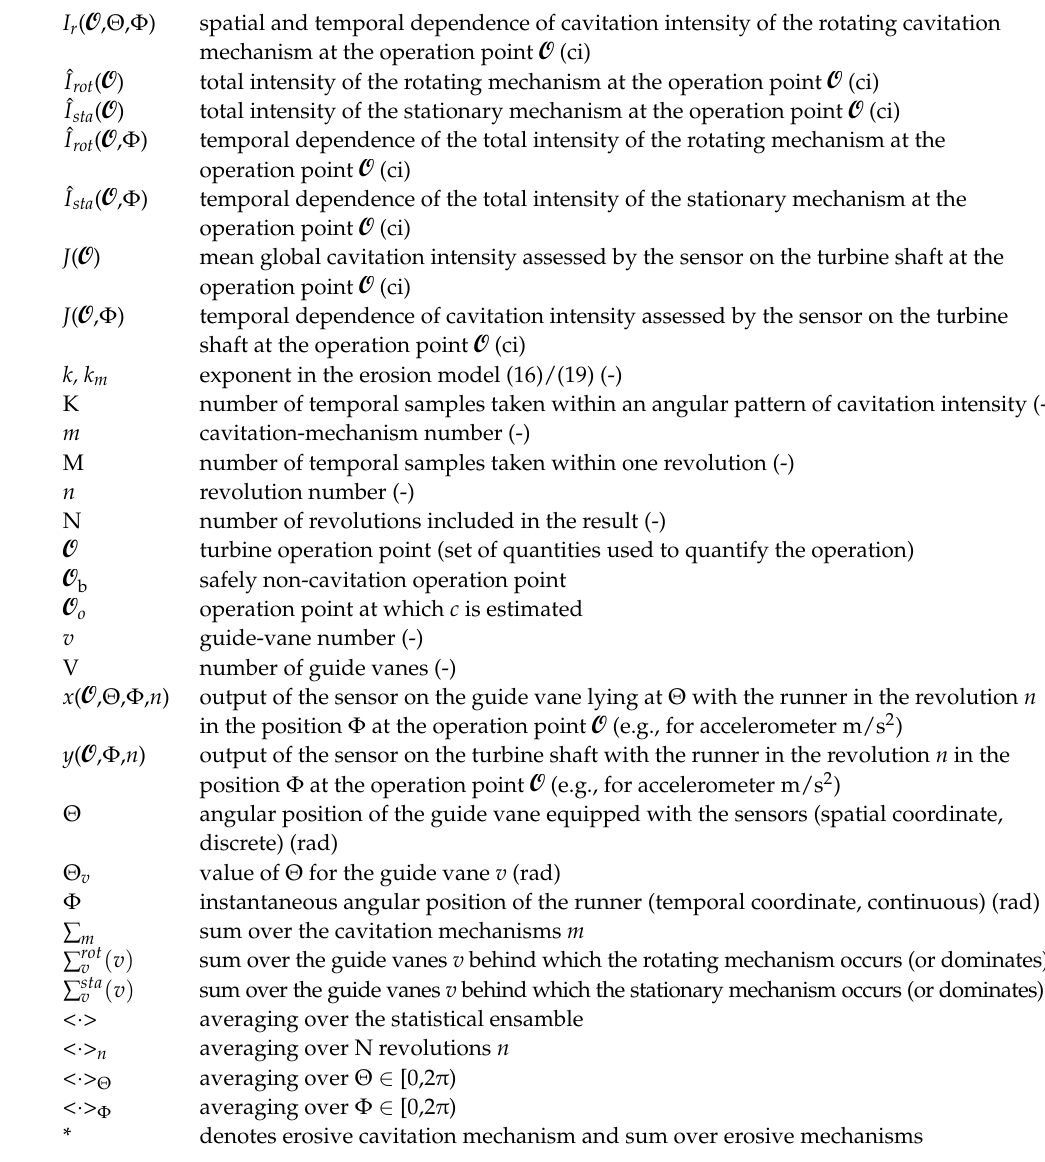
Figure 3. Front panel of the multidimensional data acquisition processor. The simplest description of cavitation comes out online after half an hour of measurement on the prototype. More compli- cated descriptions require days or weeks of recorded data analysis by a trained user.